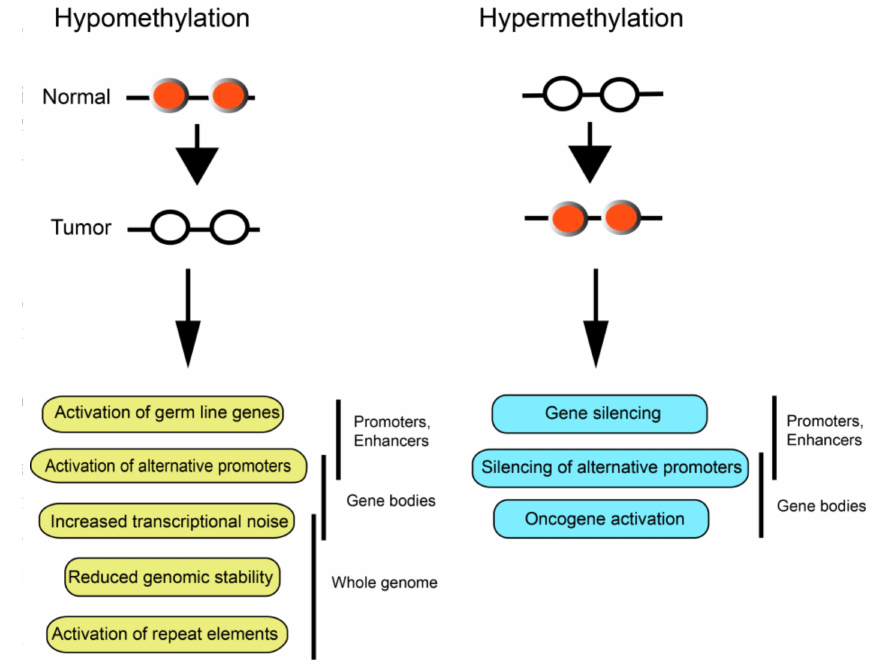
Figure 2. Genome-scale consequences of DNA hypomethylation and DNA hypermethylation in cancer. DNA hypomethylation can lead to perturbations in gene expression or genomic instability. Likewise, DNA hypermethylation may promote widespread changes in gene expression patterns through different mechanisms. White circles indicate unmethylated CpG sites and red circles show methylated CpG